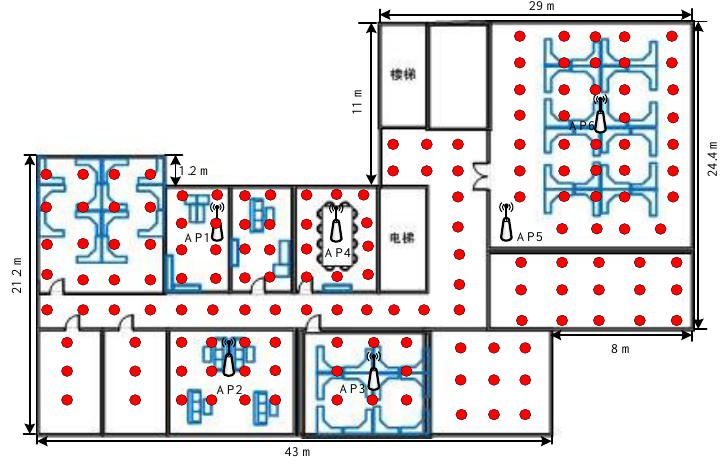
Figure 6. Layout and RPs.